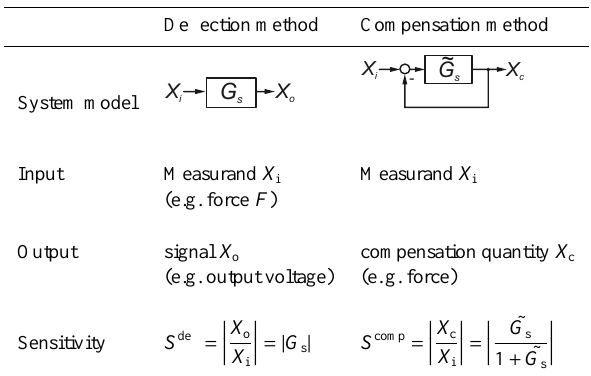
Figure 1. Simplified schematic illustration of the principle of oper- ation of (a) the deflection method and (b) the compensation method. The spring represents an arbitrary transducer, whereas the mass of the weight generally represents the input signal. Table 1. Elementary comparison between deflection method and compensation method in